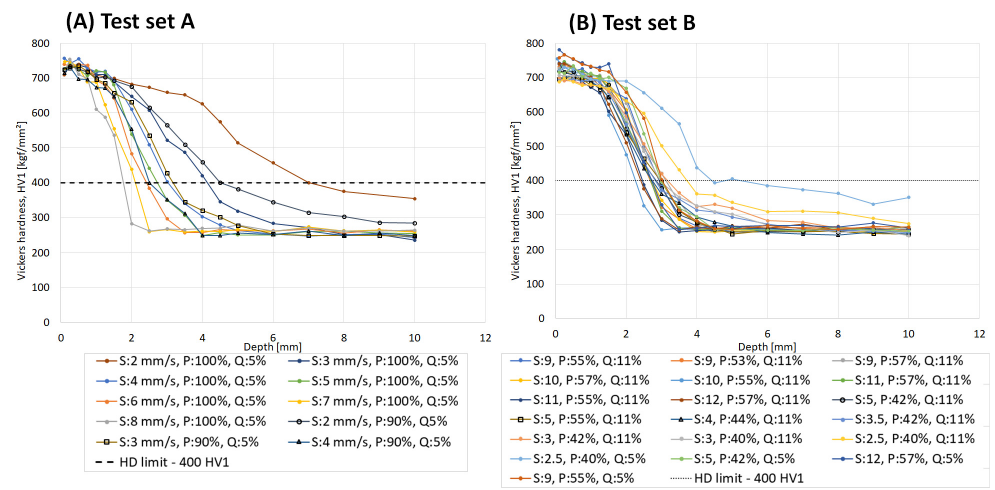
Figure 6. Hardness profiles, Vickers (HV1), for ( A ) test set A and ( B ) test set B, induction hardened samples with different scanning speed (S), power (P), and quenchant concentration (Q).